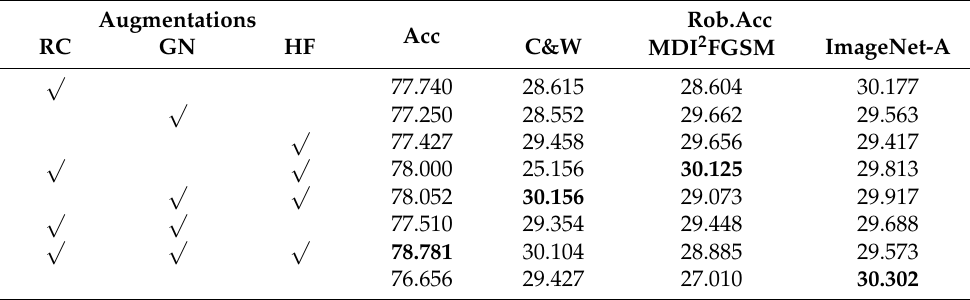
Table 6. Effect of image enhancement methods on the robustness of ASK-ViT.